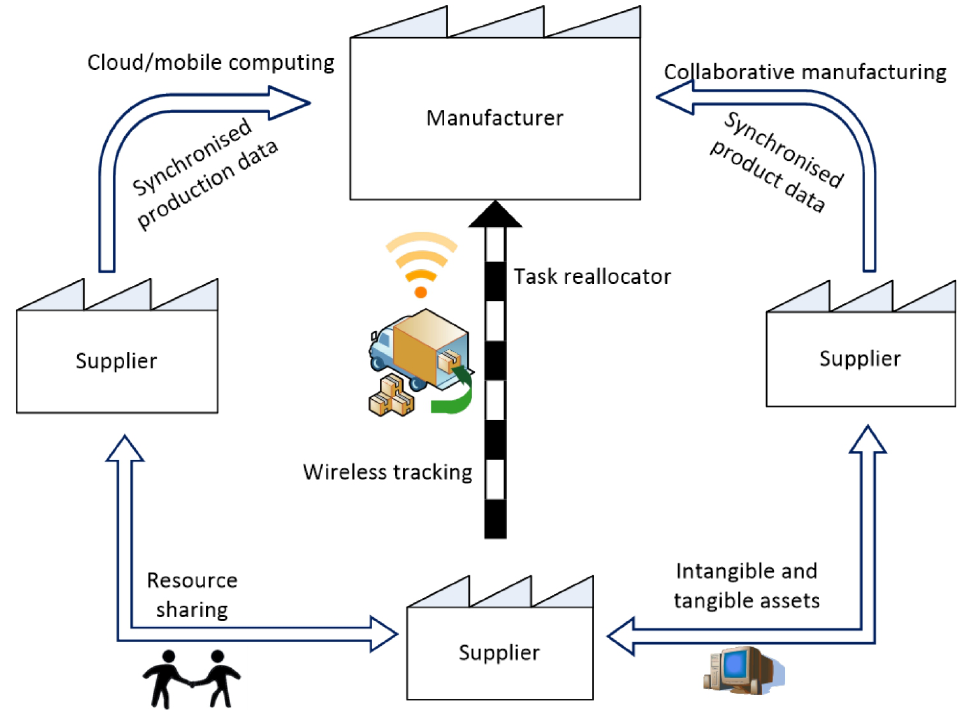
Figure 3. Impact of Industry 4.0 on supplier